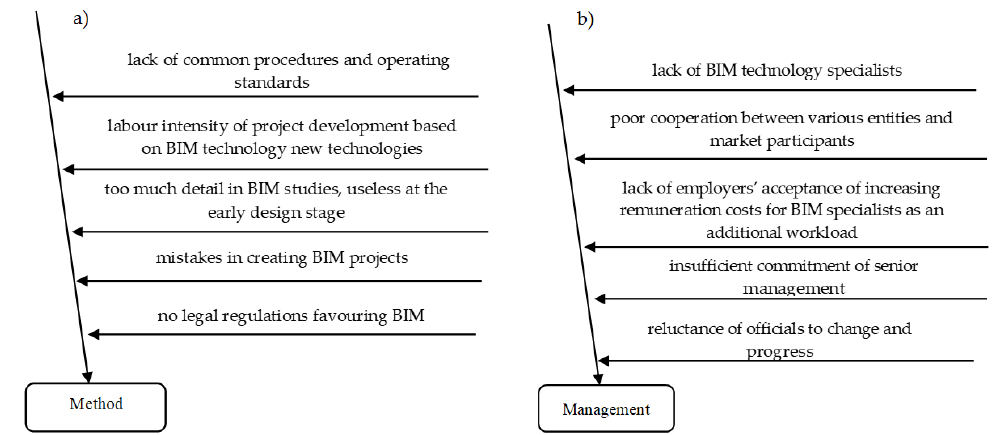
Figure 6. The reasons for the poor implementation of BIM in Poland ( a ) in the Method category; ( b ) in the Management ( b ) in the Management category.